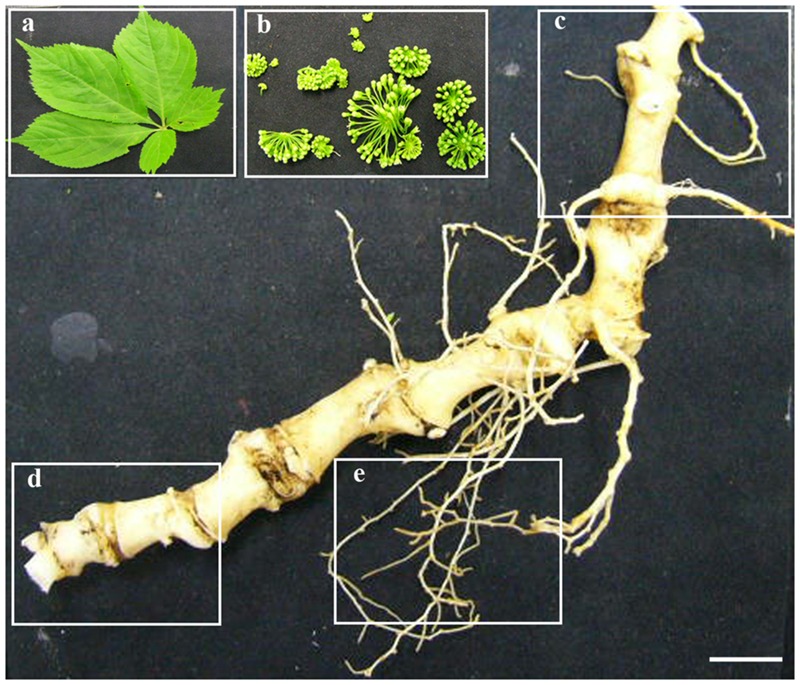
Five tissues of P. japonicus used for transcriptome study. Five tissues of P. japonicus, namely, leaf (a), flower (b), rhizome_Y (c), rhizome_O (d), and secRoot (e) were used to performed transcriptome profiling, and de novo transcriptome assembly. Scale bars for each panel measure to 0.5 cm.